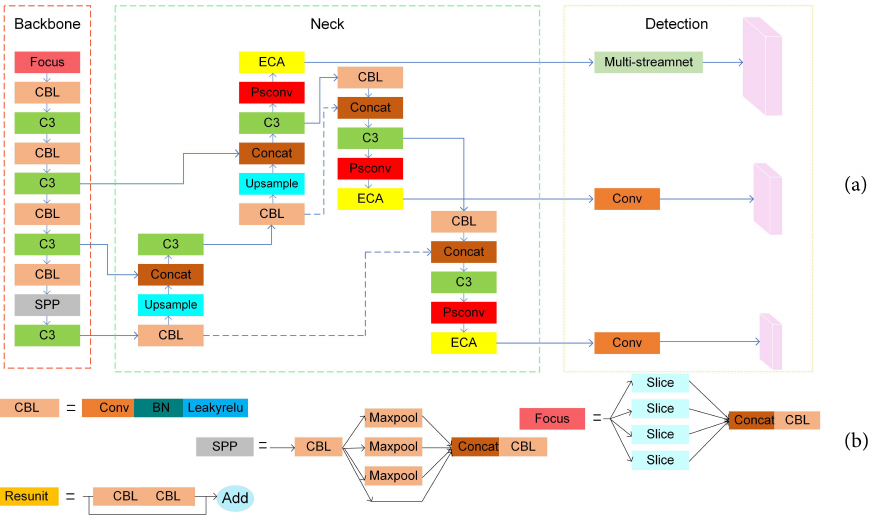
Figure 3. Schematic diagram of the structure of the MS-YOLOv5 model. ( a ) PE-NECK instead of Neck part and Multi-streamnet as first detection head; ( b ) composition of modules Focus, CBL, SPP etc.